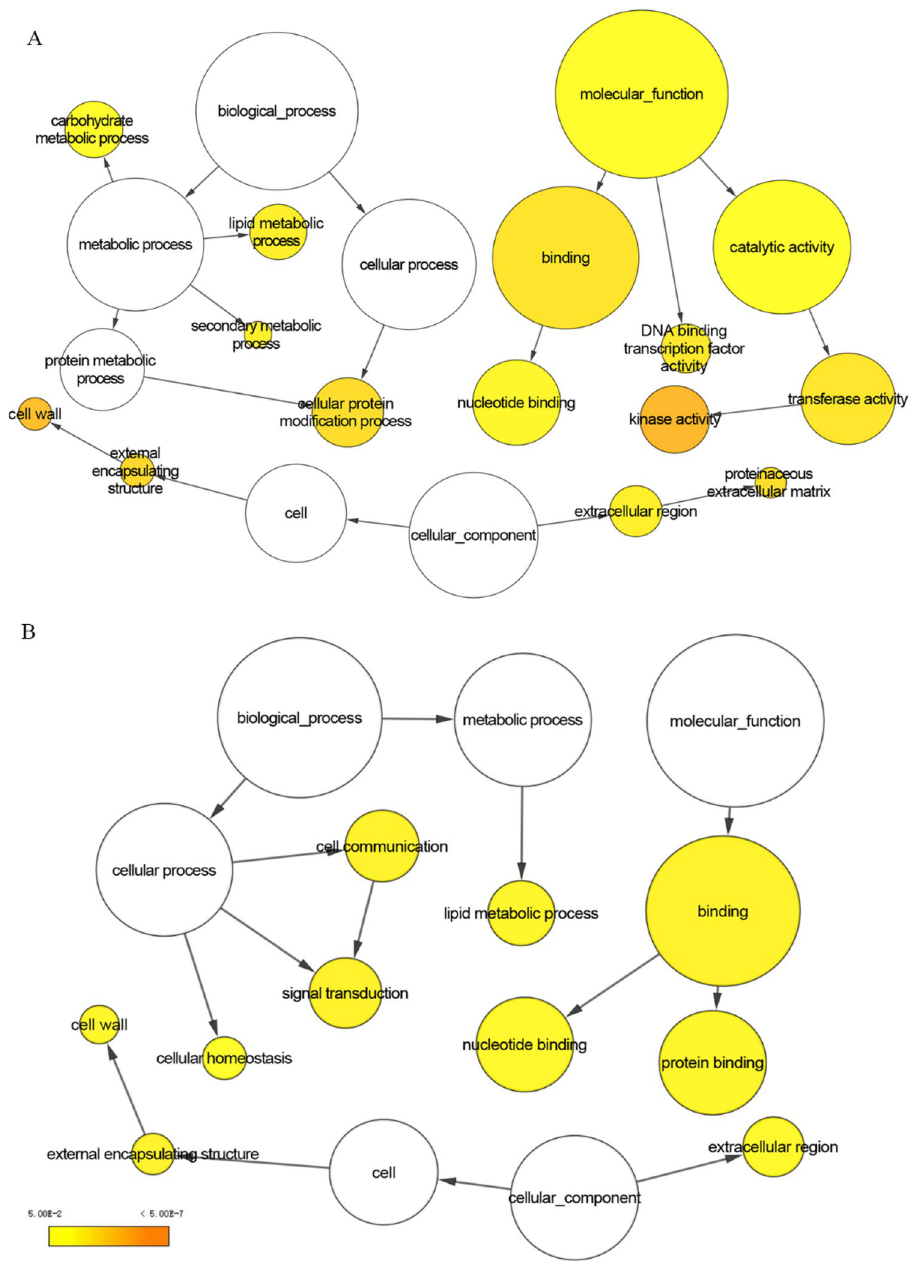
Figure 3. GO enrichment maps of DEGs under different NaCl treatments. ( A ), T100L vs T0L; ( B ) T400L vs T0L. Node size represents the gene number per node, and the colour of the node represents the p